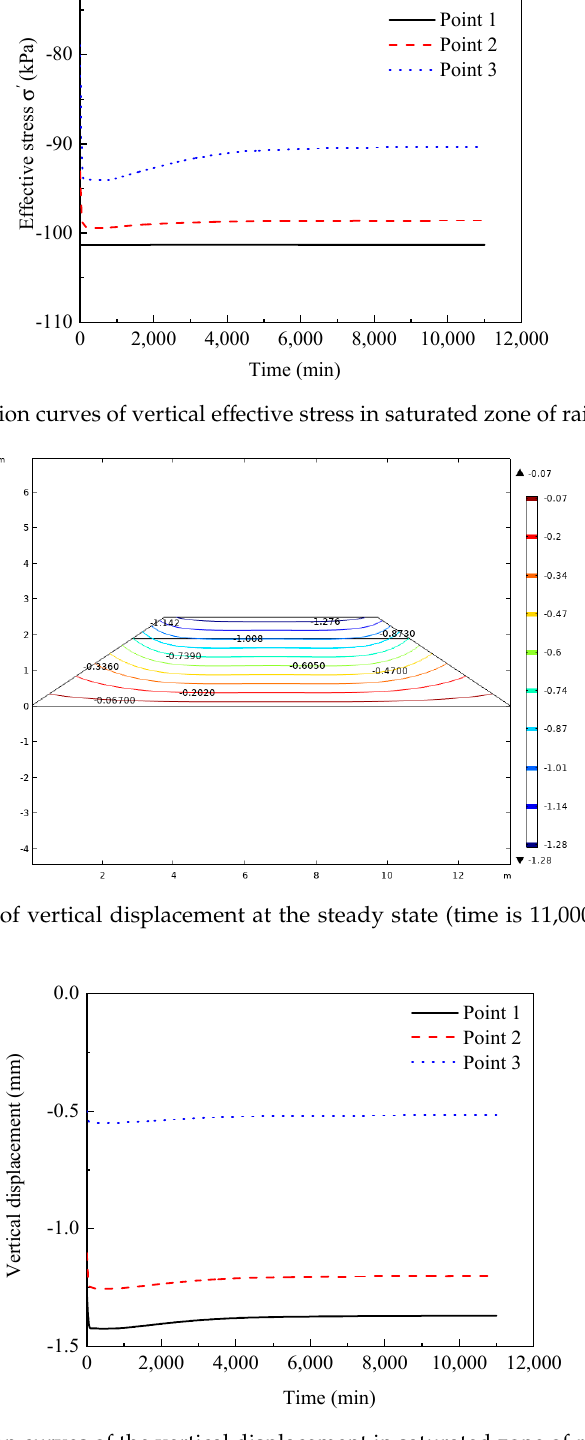
Figure 19. Evolution curves of vertical effective stress in saturated zone of railway subgrade.